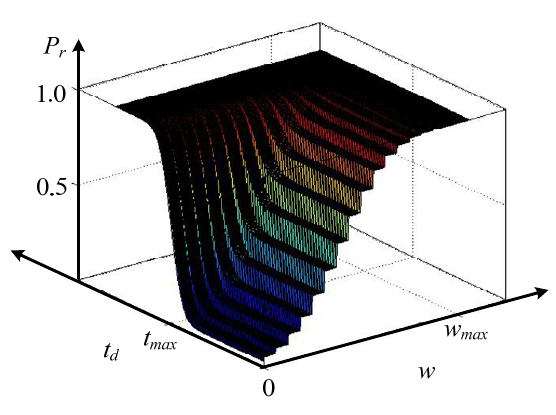
Figure 11. Refuse-operation probability for consistent delays and bit errors.